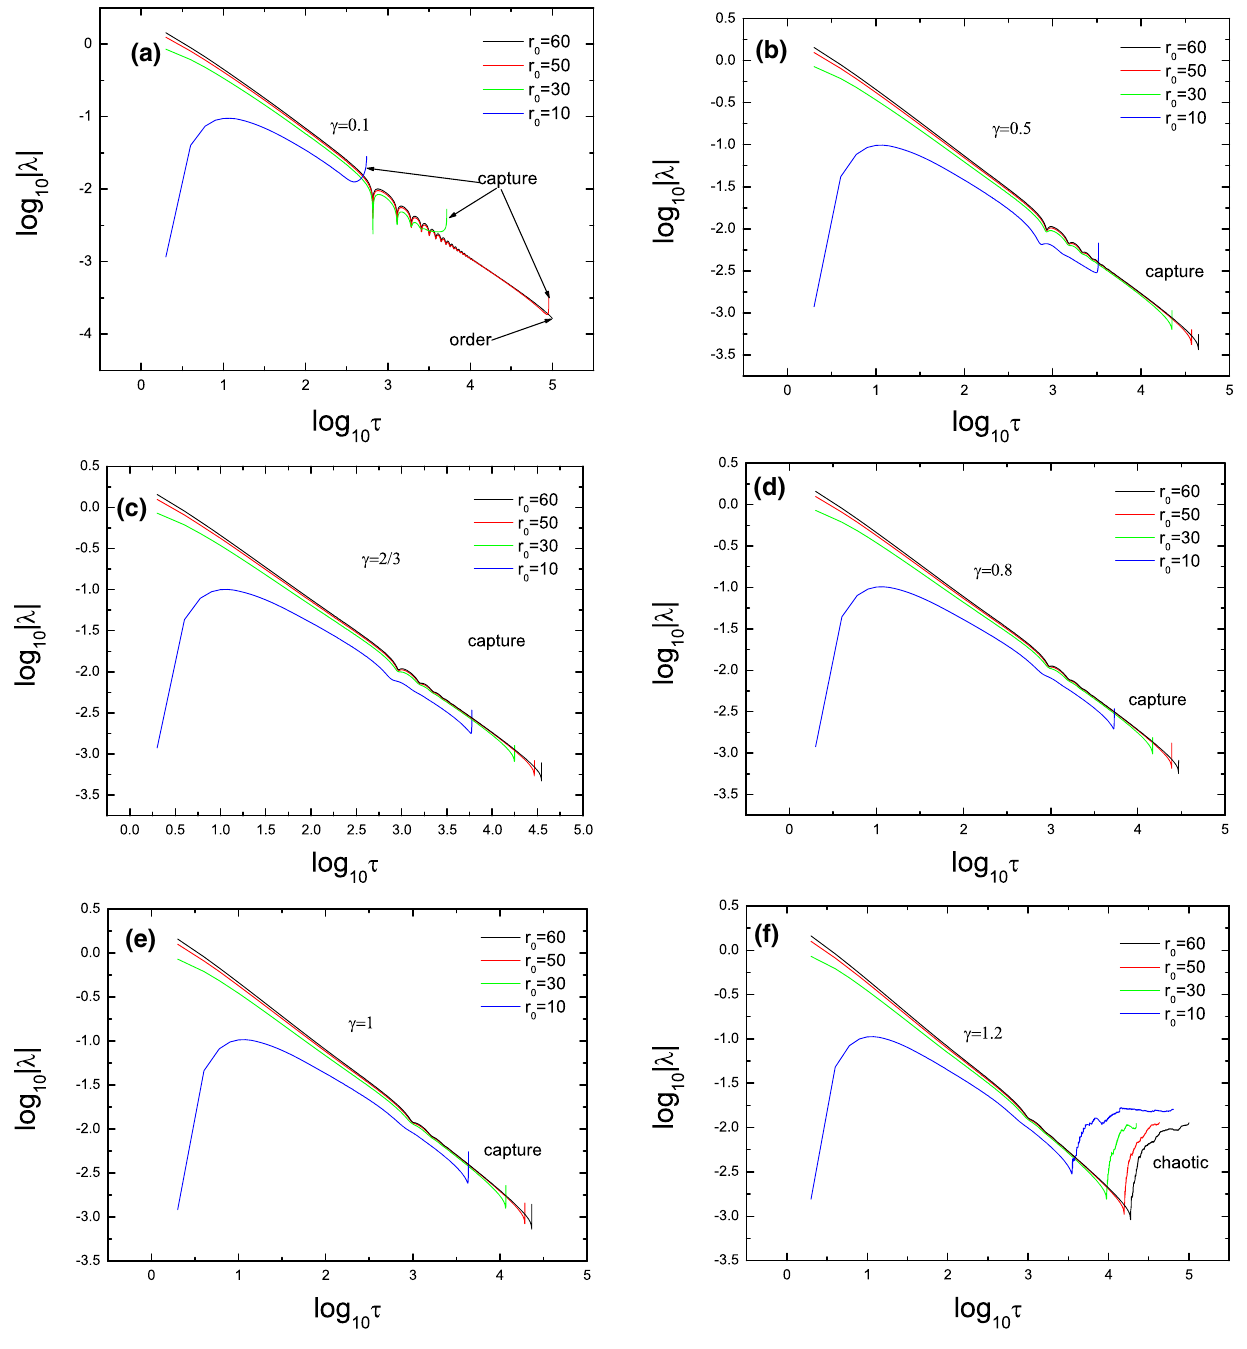
Fig. 5 The maximum Lyapunov exponents of the string trajectory for fixed γ with different initial position r 0 = 10 , 30 , 50 , 60